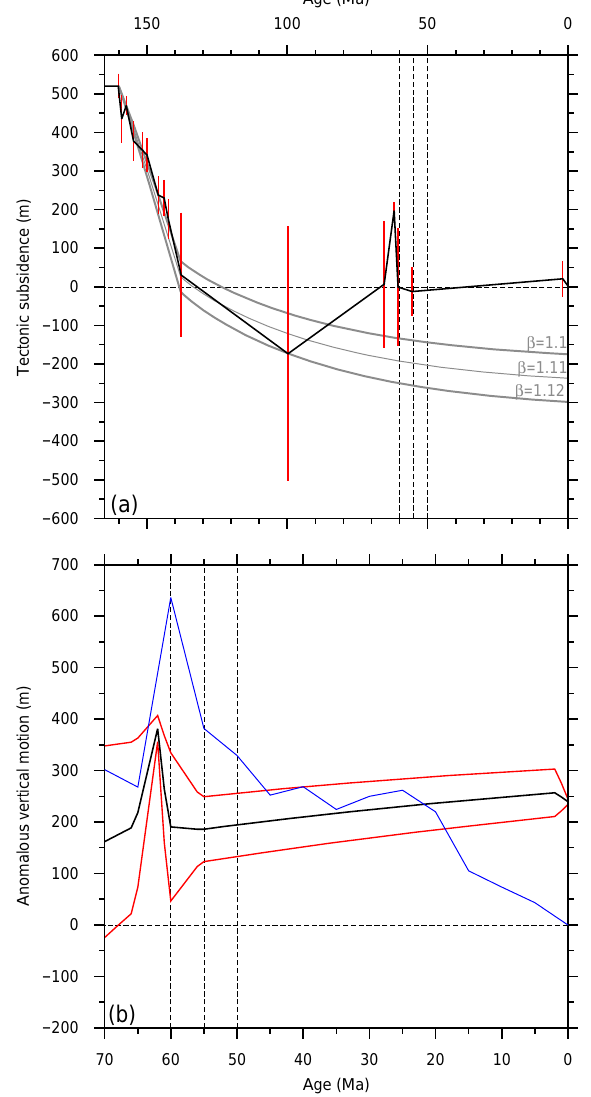
Figure 8. (a) An example of comparing a backstripped water- loaded tectonic subsidence history (solid black curve; Clift and Turner, 1998) against several corresponding modelled water-loaded tectonic subsidence histories (light-grey curves; Jarvis and McKen- zie, 1980) from well 13-27-1 in the North Sea. Deviations between these curves can be interpreted as anomalous subsidence inconsis- tent with expected post-rift thermal subsidence (Jarvis and McKen- zie, 1980). Red bars represent errors in subsidence magnitudes re- lated to uncertainties in palaeobathymetry depth estimates (Clift and Turner, 1998). The solid blue curve is the model dynamic topogra- phy at this well location (Sect. 2.2.3; Fig. 3). The three vertical light- grey dotted lines represent ages 60, 55, and 50Ma; the horizontal grey dotted line is zero elevation. (b) Anomalous vertical motion (thick black curve) calculated by subtracting the best-fit modelled tectonic subsidence history ( β = 1.11) away from the subsidence history in (a) , focused on the last 70Myr. Red curves represent er- rors in anomalous subsidence estimates related to the uncertainty in palaeobathymetry depth mentioned in (a) . Thin grey dotted lines and blue curve same as in (a)